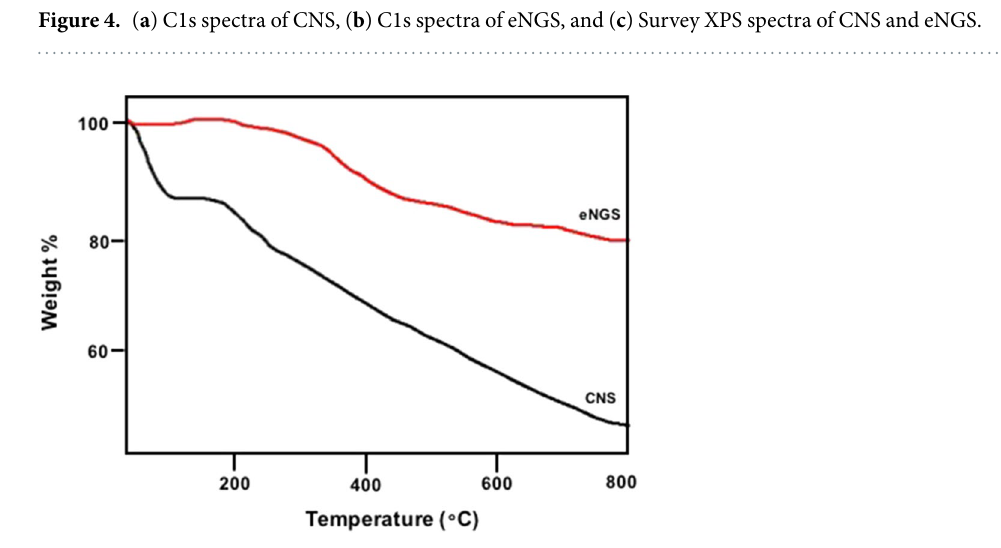
Figure 5. TGA of CNS and eNGS under N 2